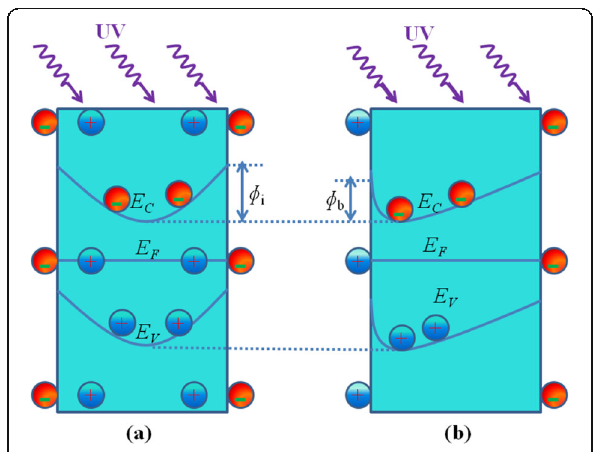
Fig. 9 a The band diagram for an unbent MW: the conduction and valence band edges are bent near the surface due to the surface pinning of Fermi level. The intrinsic surface recombination barrier ɸ i is also shown. b The case for a bent MW: the piezo-induced electric field lowers the surface recombination barrier from ɸ i to ɸ